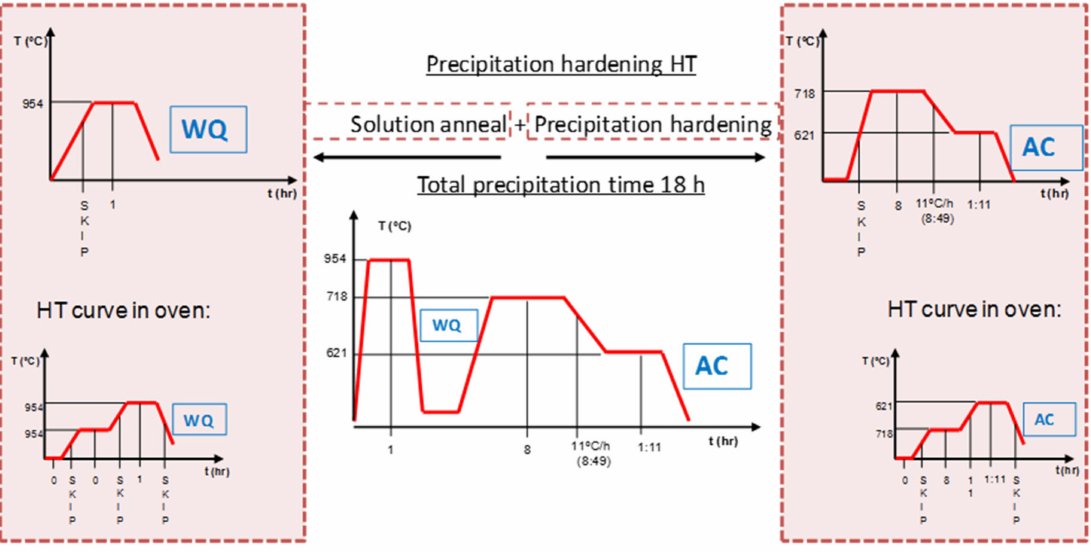
Figure 9. Two heat treatments suitable for IN718